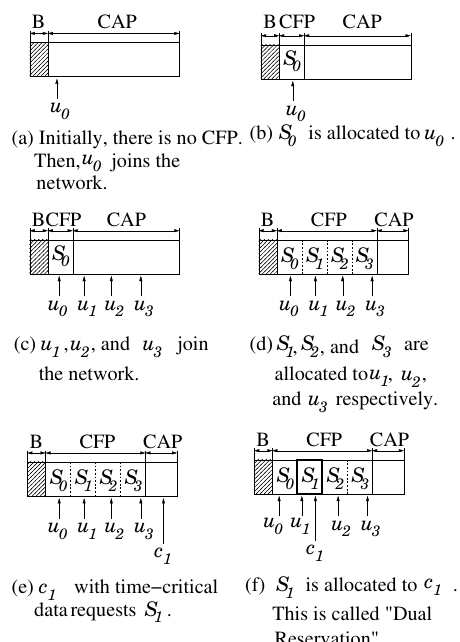
Figure 2. Dual reservation process of the CoR-MAC (B denotes beacon). CAP, contention access phase; CFP, contention-free phase.